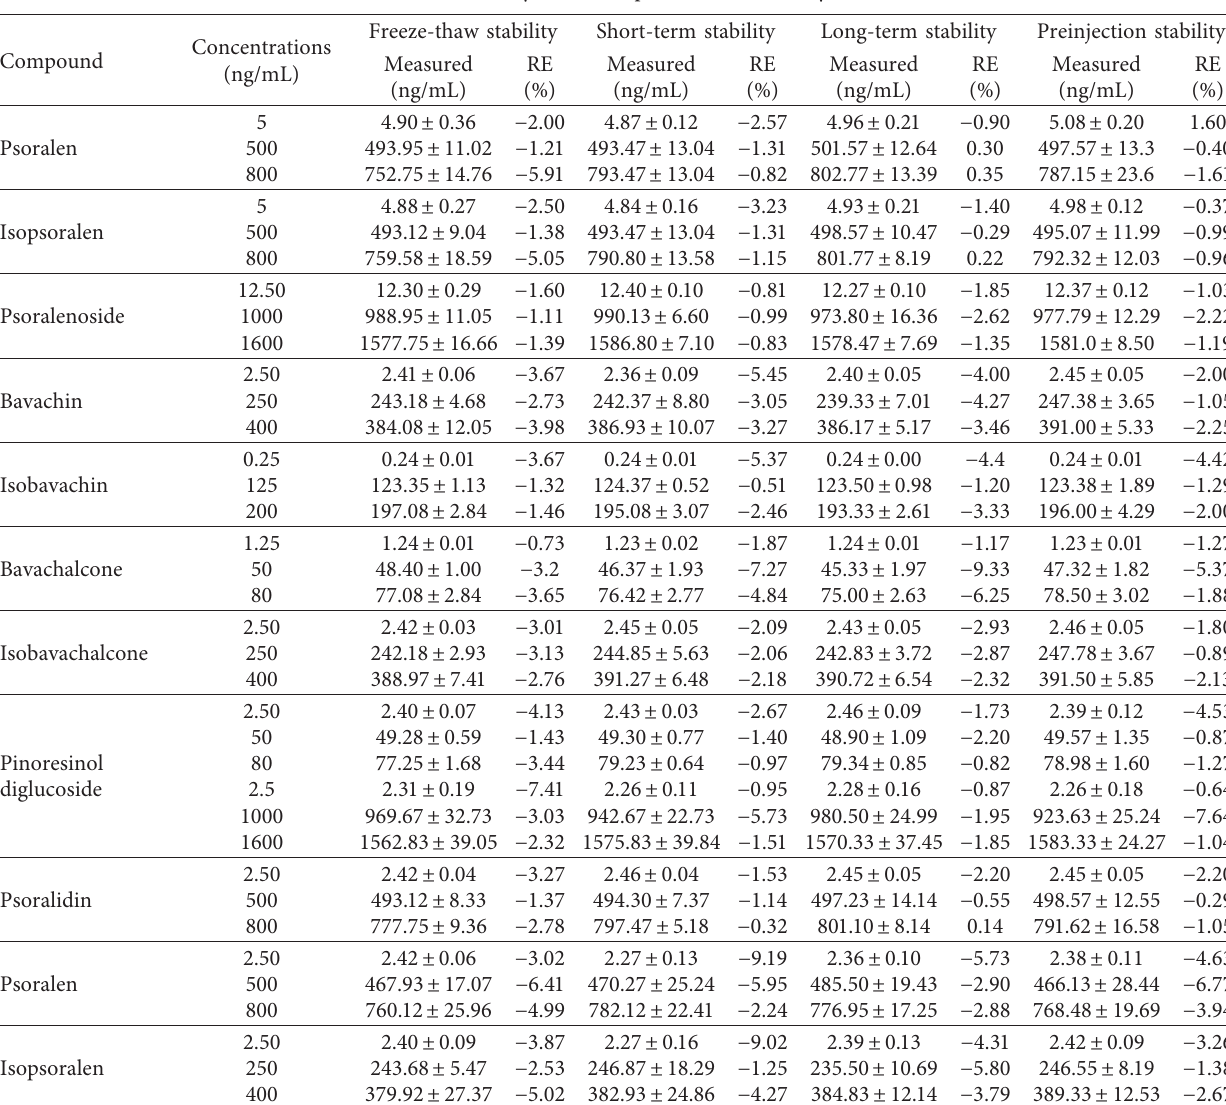
Table 5: The stability of 12 compounds in rat kidney ( n �